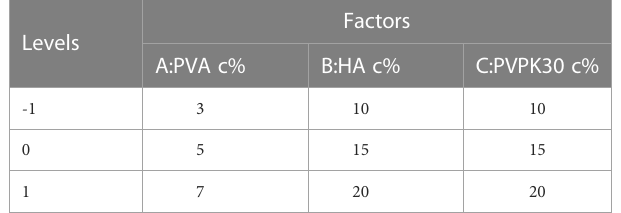
TABLE 1 Factors and levels in the